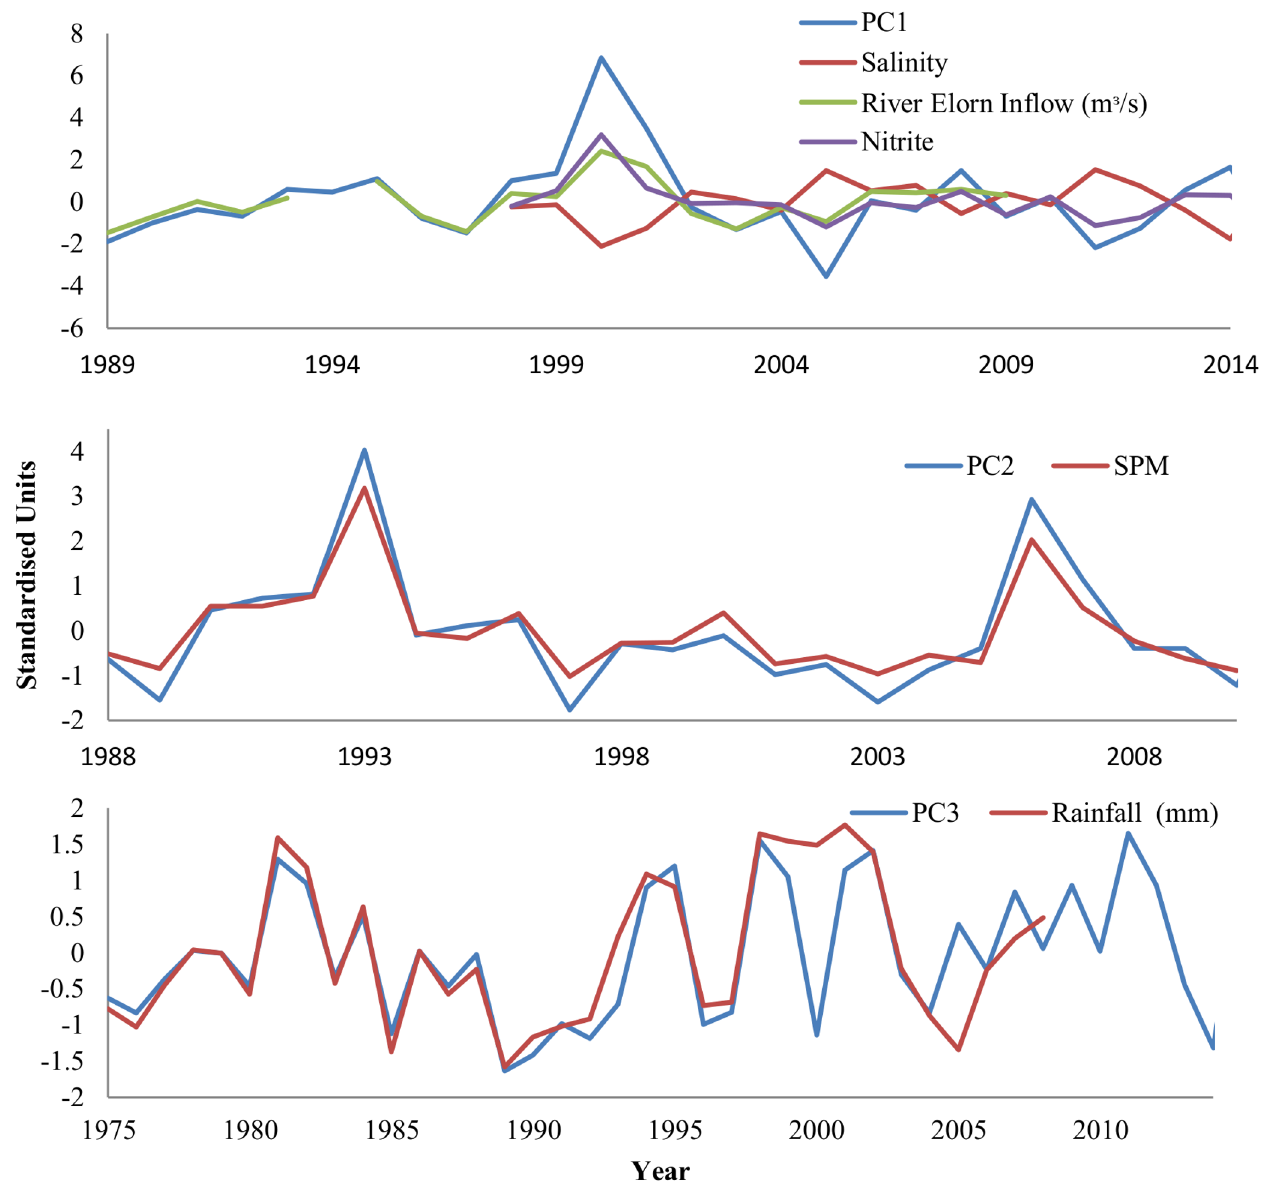
Fig 6. Environmental data with the respective leading principle component (PC) scores. Environmental parametersincludedin analysis are: salinity, River Elorn inflow rate, nitrite levels and rainfall. Each environmental parameter was normalised (mean = 0, variance= 1).